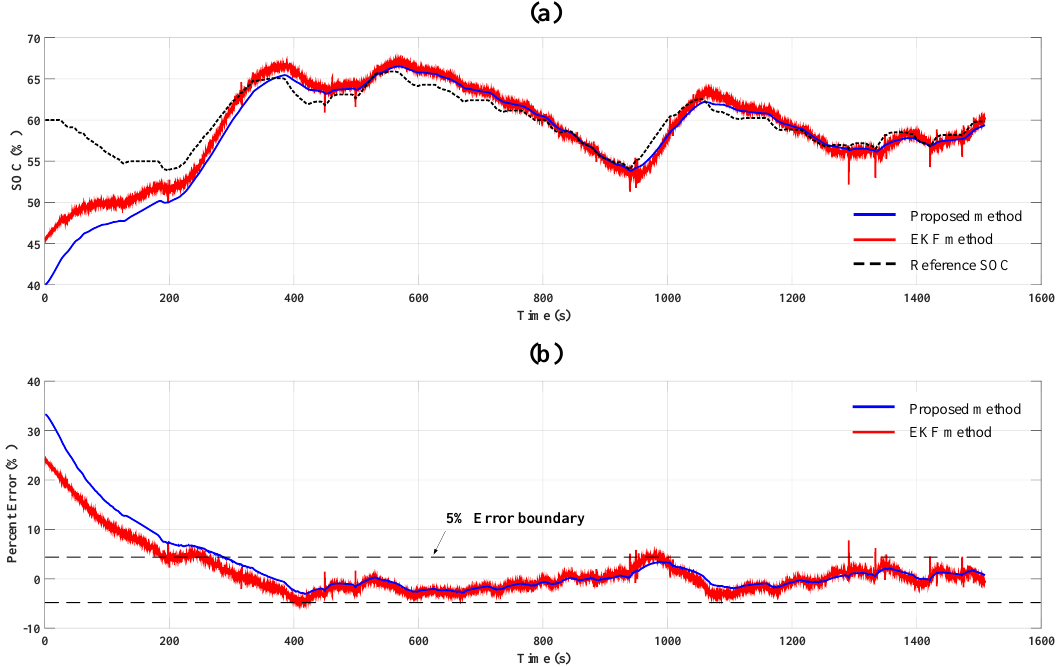
Figure 12. SOC estimation results with voltage sensor noise: ( a ) SOC estimation results of the two types of methods and ( b ) percentage error of each